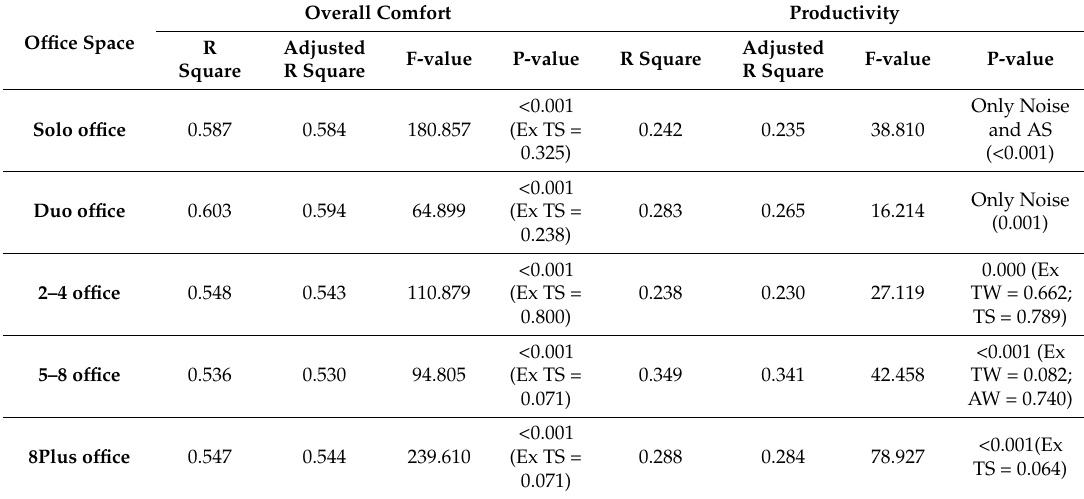
Table 4. Impact of IEQ variables on overall comfort and productivity in all five office types.